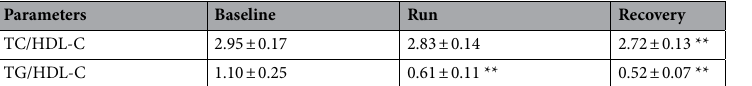
Table 2. The molar ratios of total cholesterol to high-density lipoprotein-cholesterol (TC/HDL-C) and triacylglycerols to high-density lipoprotein-cholesterol (TG/HDL-C) before (Baseline), immediately after marathon (Run) and at 90 min of recovery (Recovery) ( n = 11). The values are means ± SEM. Asterisks denote significant differences from the resting values: **P < 0.01.